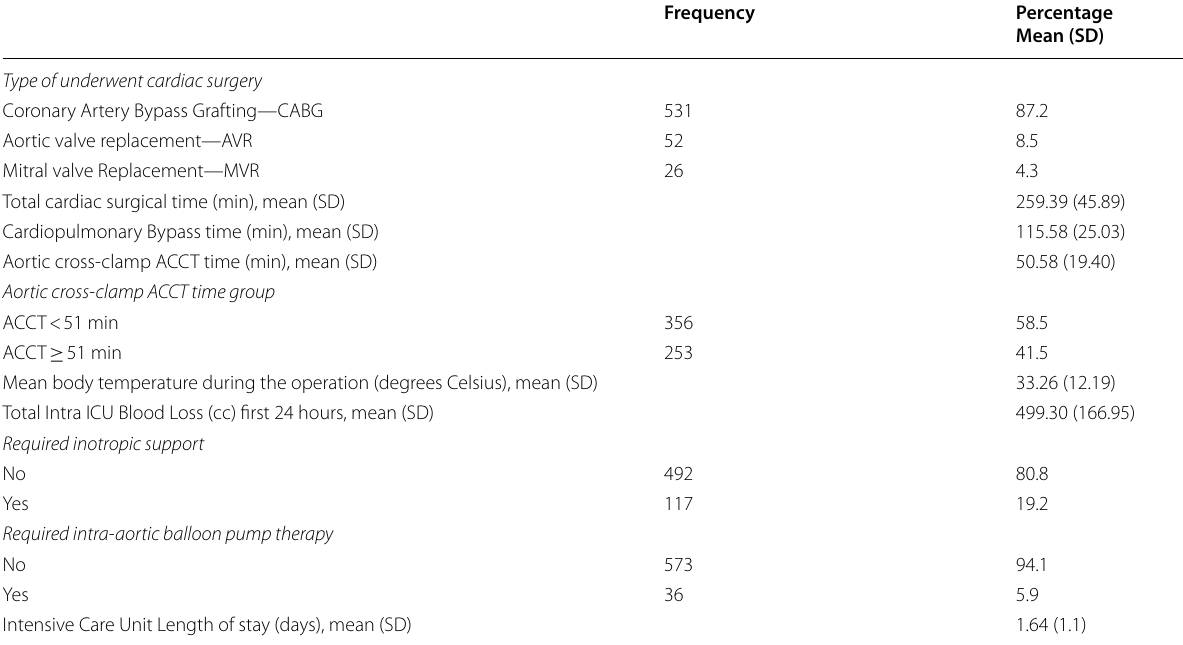
Table 2 Descriptive analysis of the patients’ cardiac surgical characteristics and